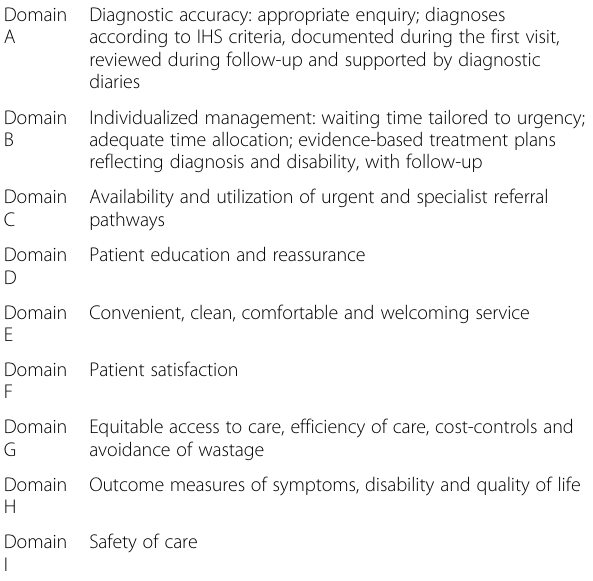
Table 1 The nine domains of quality in a headache